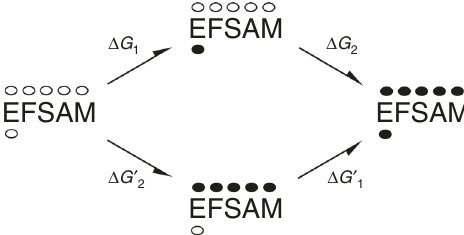
Fig. 8 Energetic coupling of the EF-hand site and the EFSAM surface